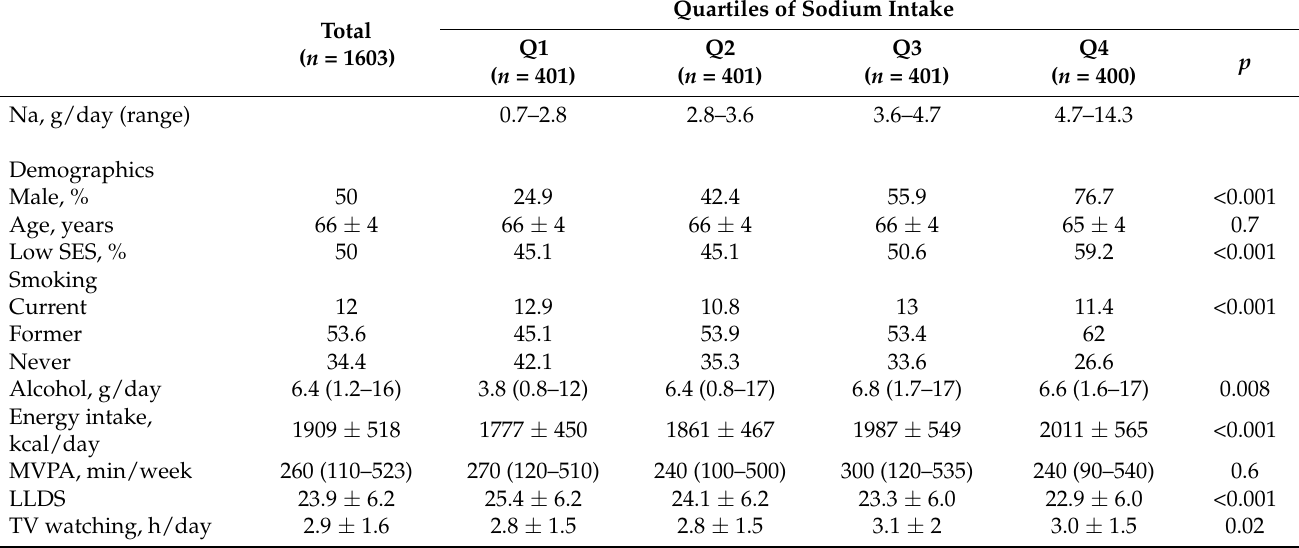
Table 1. Baseline characteristics of the MINUTHE cohort for total population and population dis- tributed by equal sodium intake